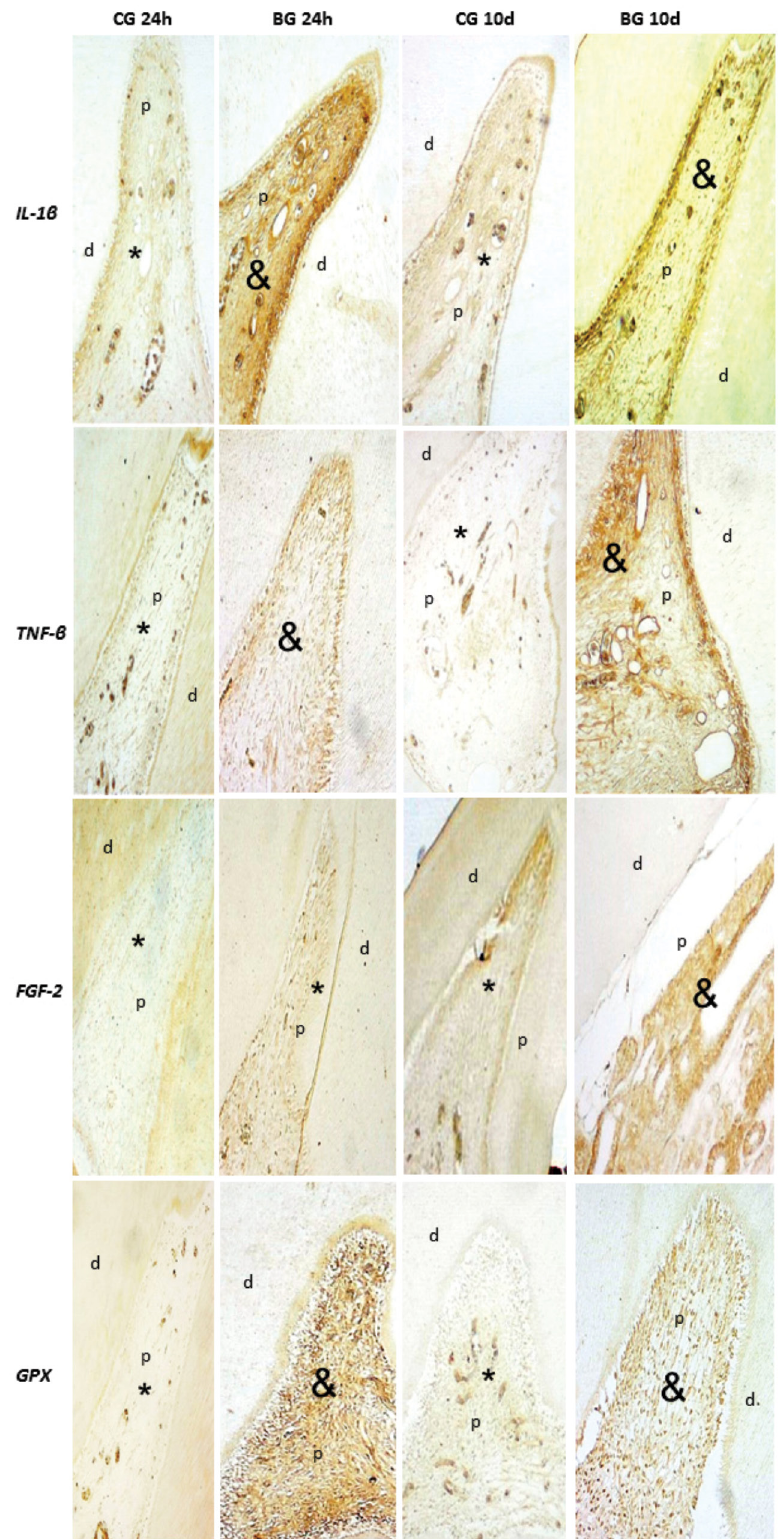
Figure 2- Immunohistochemistry analysis: CG 24h (control group 24 hours); CG 10d (control group 10 days); BG 24 h (bleached group 24 hours); BG 10d (bleached group 10 days). d=dentin, p=pulp. Il-1β ; TNF-β ; FGF and GPX . *Pulp presenting weak staining; & Pulp presenting strong